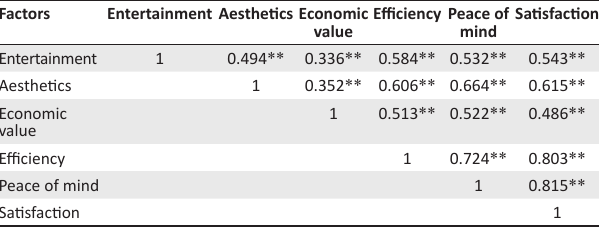
TABLE 4: Correlations between factor